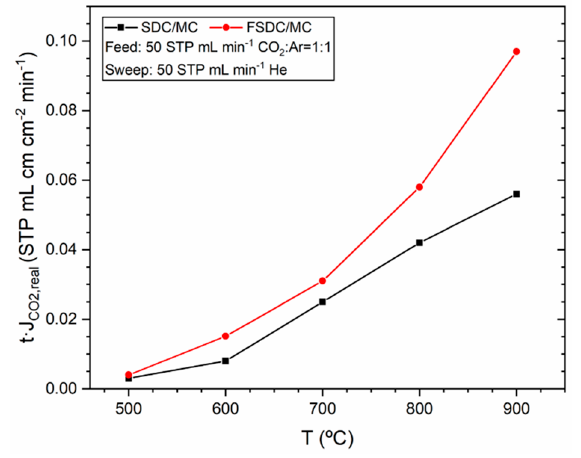
Figure 6. CO 2 flux density multiplied by membrane thickness as function of the temperature for the SDC and FSDC DP membranes.